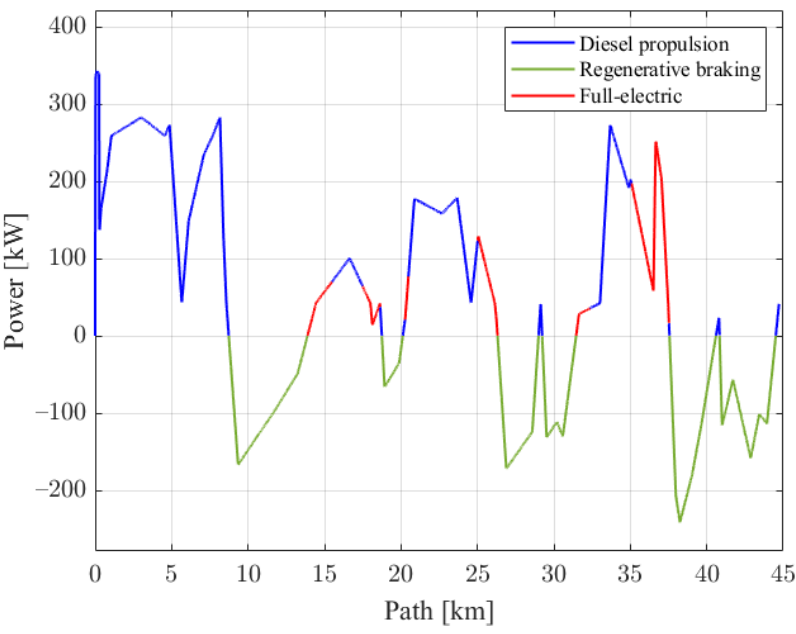
Figure 14. Overall power delivered according to the operative modes over the entire